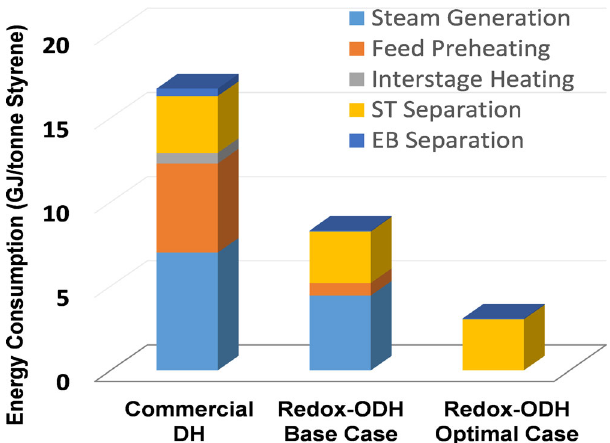
Fig. 7 Process analyses. Energy intensities of commercial DH and redox- ODH for styrene production based on ASPEN Plus